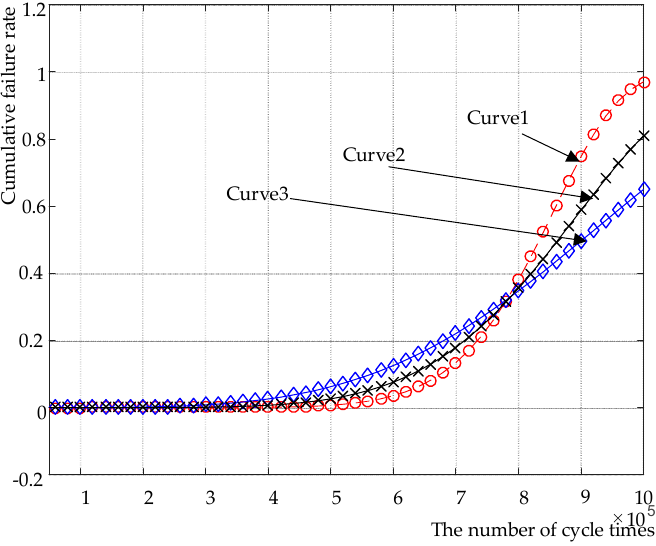
Figure 13. Weibull distribution function curves fitted under different weights.